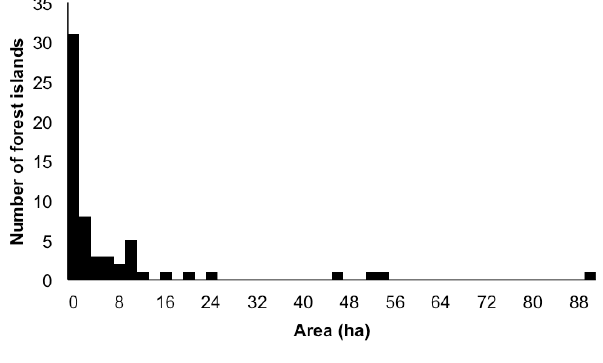
Fig. 2 . Area of surveyed islands in northern